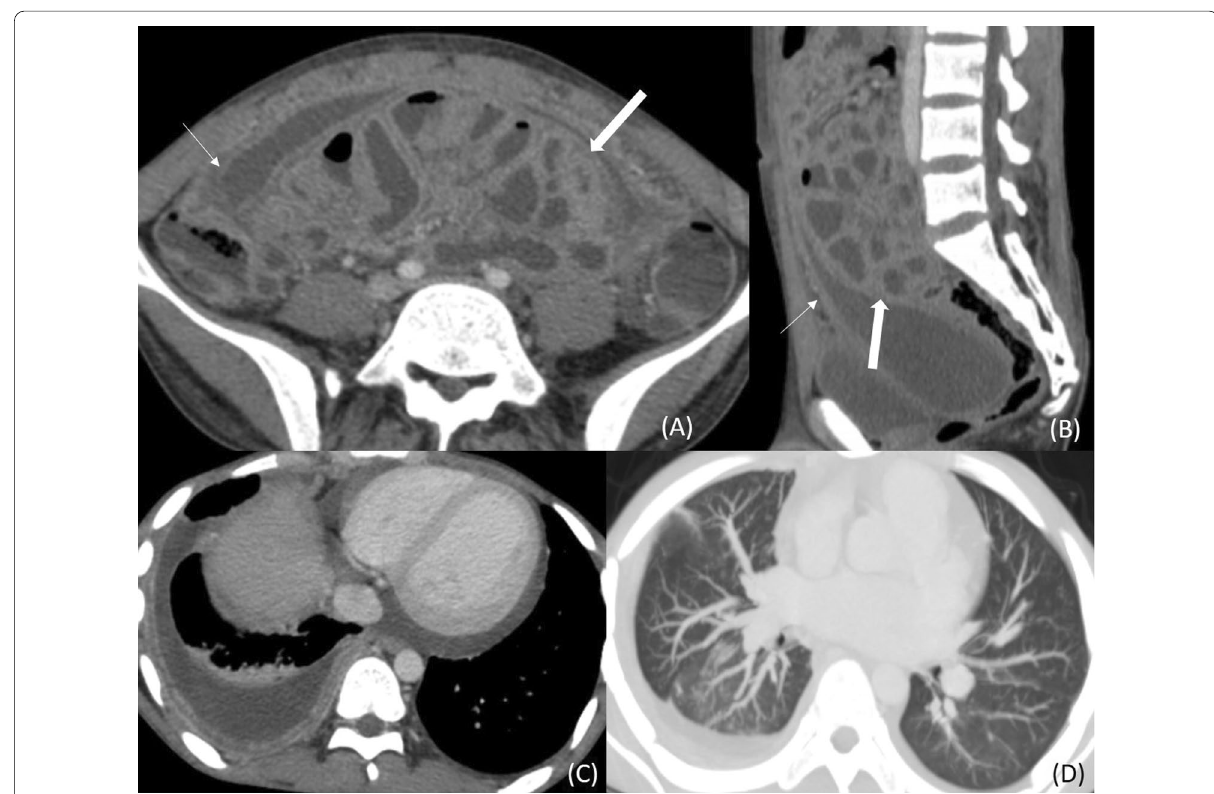
Fig. 18 Abdominal cocoon. Abdominal CT images of 23-year-old male show clumping of small bowel loops in centre of abdominal cavity surrounded by thick and enhancing membrane (solid arrow in A , B ), there is gross ascites and thickening of peritoneal membrane (thin arrow in A , B ), thorax CT shows pericardial effusion and right pleural effusion with thickening of parietal pleura, suggestive of empyema ( C ) and lung window shows randomly distributed nodules in the right lower lobe ( D